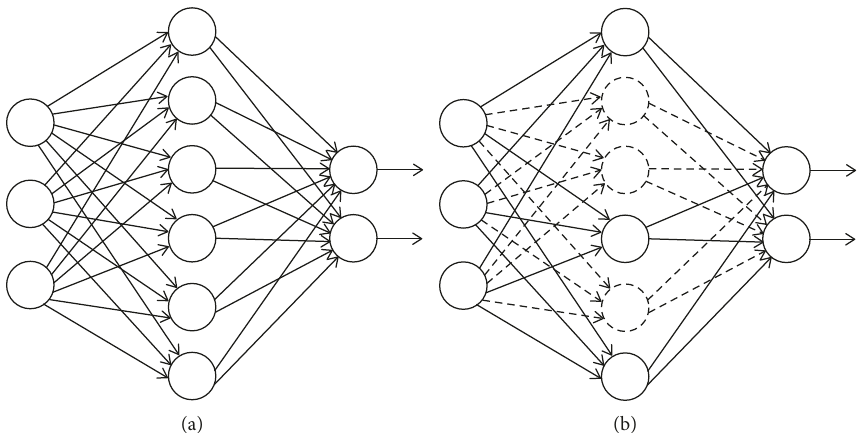
Figure 7: Structures of ANN with/without dropout. (a) ANN without dropout. (b) ANN without dropout.